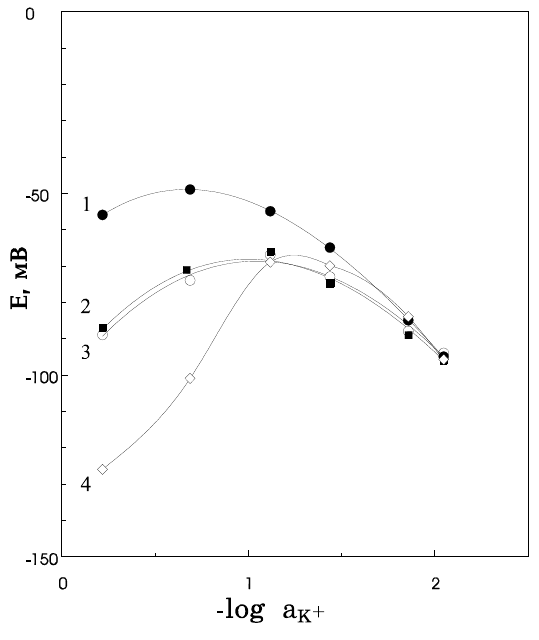
Figure 4. Calibration curves for polyurethane membranes containing K-TpClPB and a plasticizer in solutions of highly lipophilic anion (KCNS). The membranes differ in the UV exposure time used for polymerisation: 1–2 minutes of irradiation; 2–10 minutes; 3–20 minutes; 4-membrane without K-TpClPB and with 2 minutes of